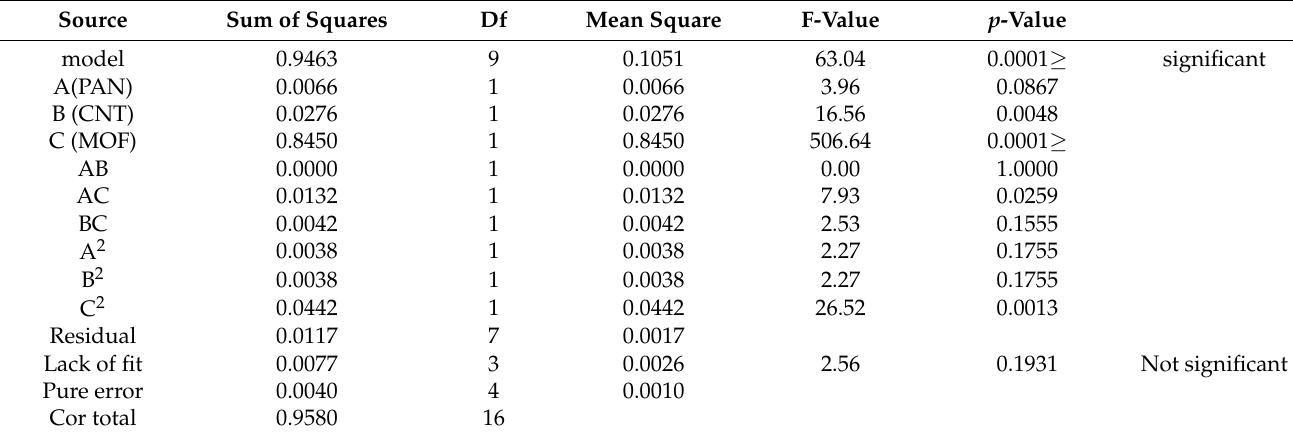
Table 3. Statistical parameters of the ANOVA